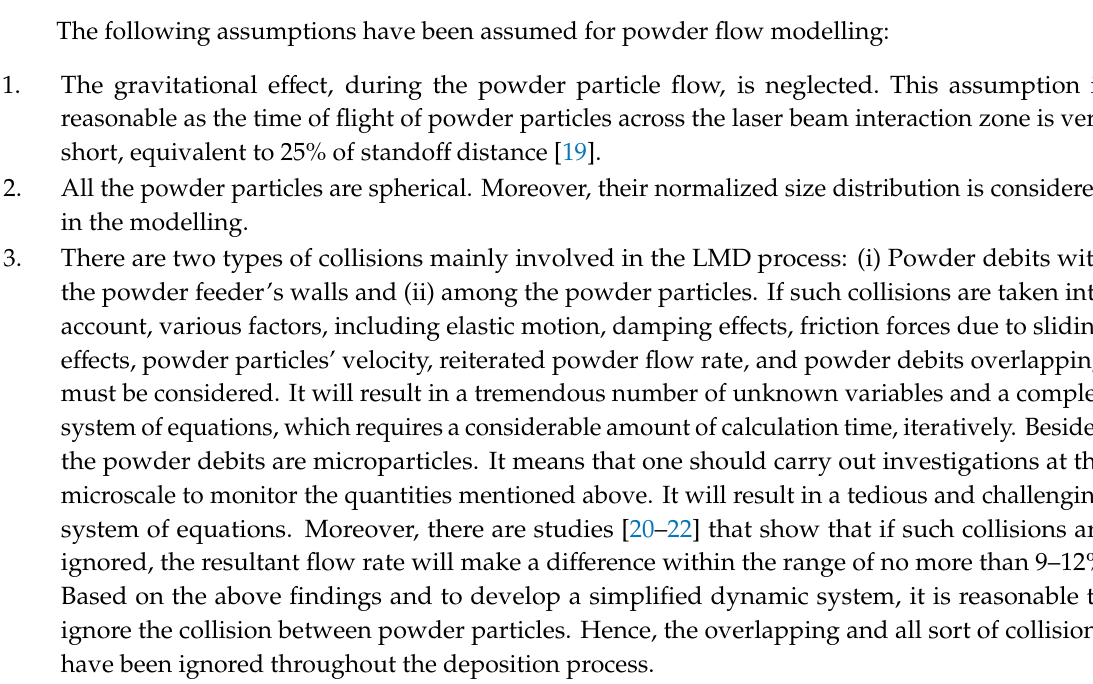
Figure 1. Graphical representation of a three-jet powder nozzle: ( a ) 3D, and ( b ) 2D.